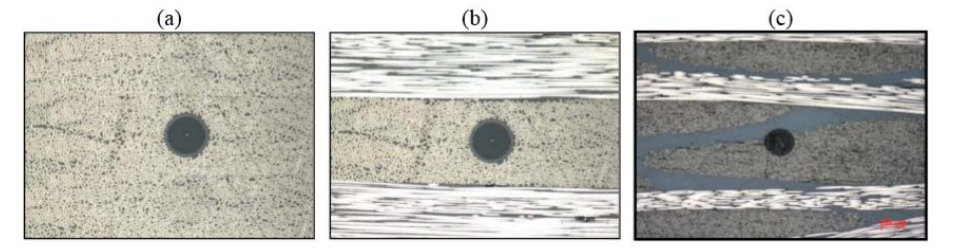
Figure 7. Optical fibre section in ( a ) unidirectional; ( b ) cross-ply and ( c ) woven fabric